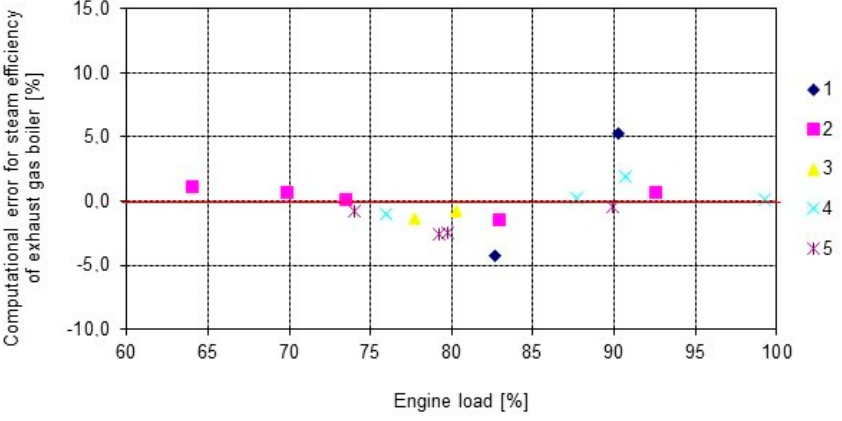
Figure 9. Computational errors for steam efficiency of exhaust gas boiler.